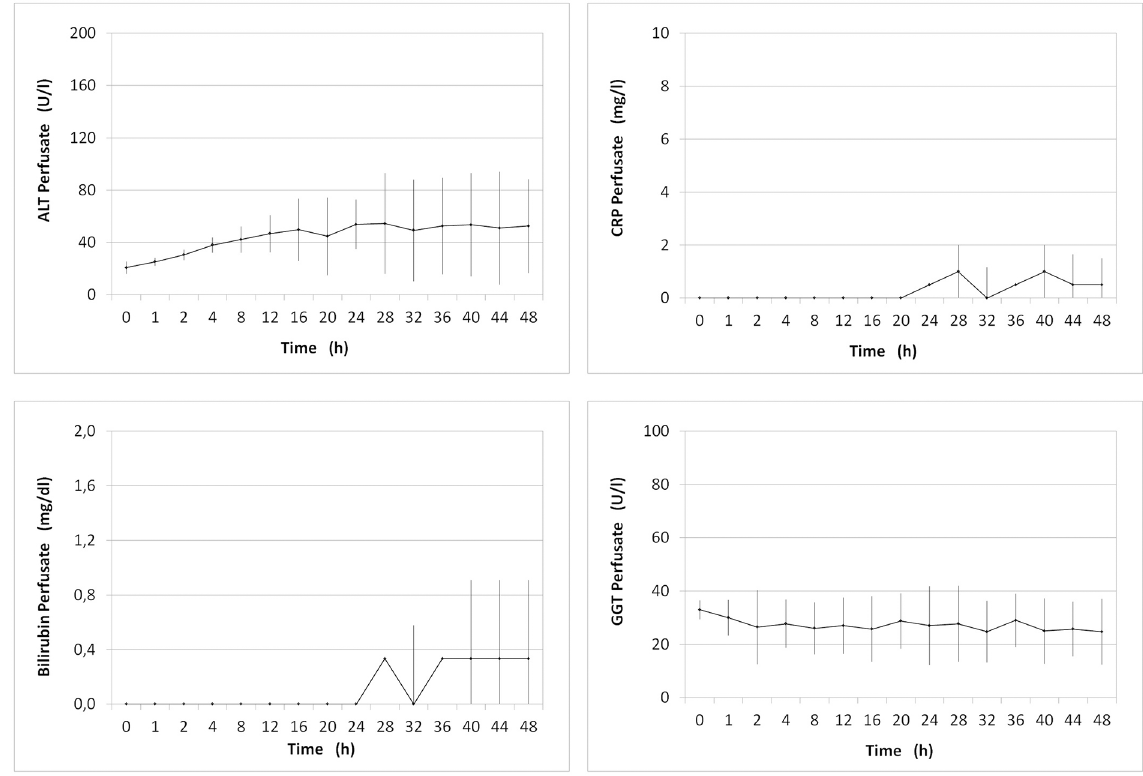
Fig 7. Markersof cellular injury. ALT, CRP, Bilirubinand GGT measuredin perfusateduringnormothermic machine perfusion ± SD.